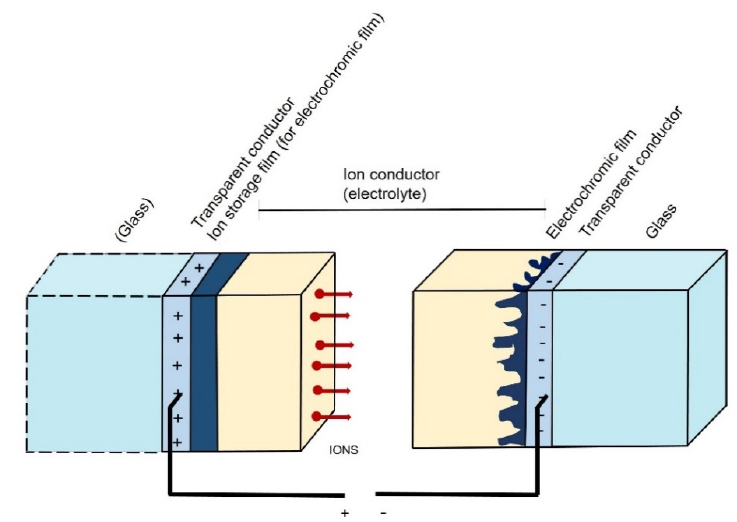
Figure 7. The five-layer stack of a generic EC device, with a “battery-like”